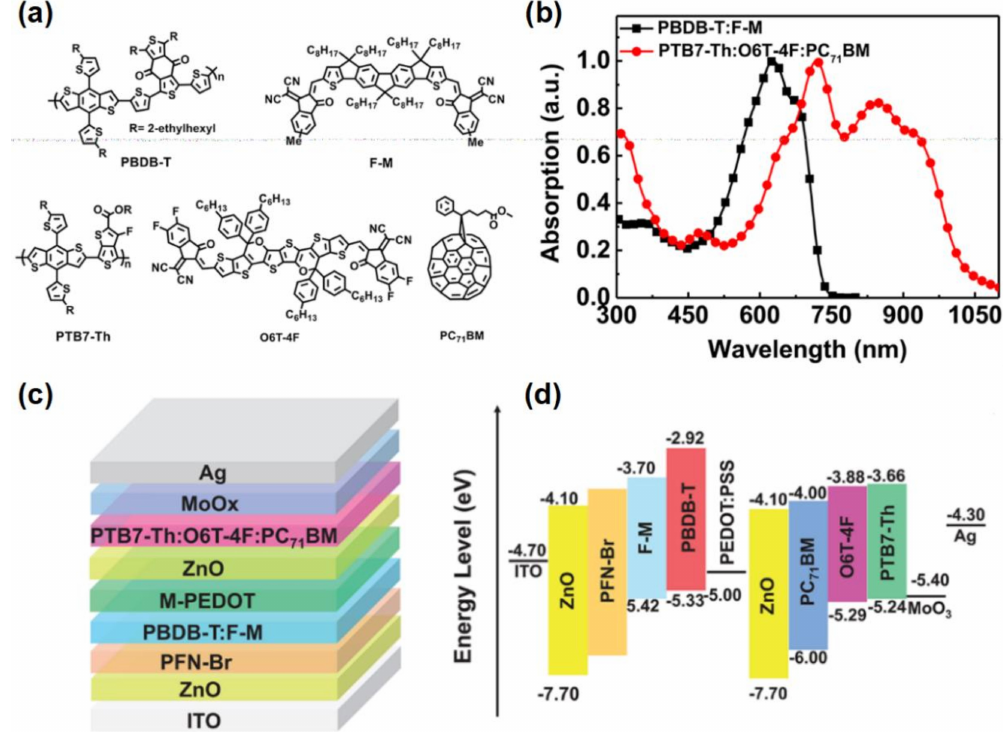
Figure 17. ( a )MolecularstructuresofPBDB-T,F-M,PTB7-Th,O6T-4FandPC 71 BM;( b )Normalizedabsorption spectra of PBDB-T:F-M and PTB7-Th:O6T-4F:PC 71 BM films; ( c ) and ( d ) Device architecture and energy level diagram of the tandem cell, respectively (reproduced from Reference [264] with permission, copyright Science,